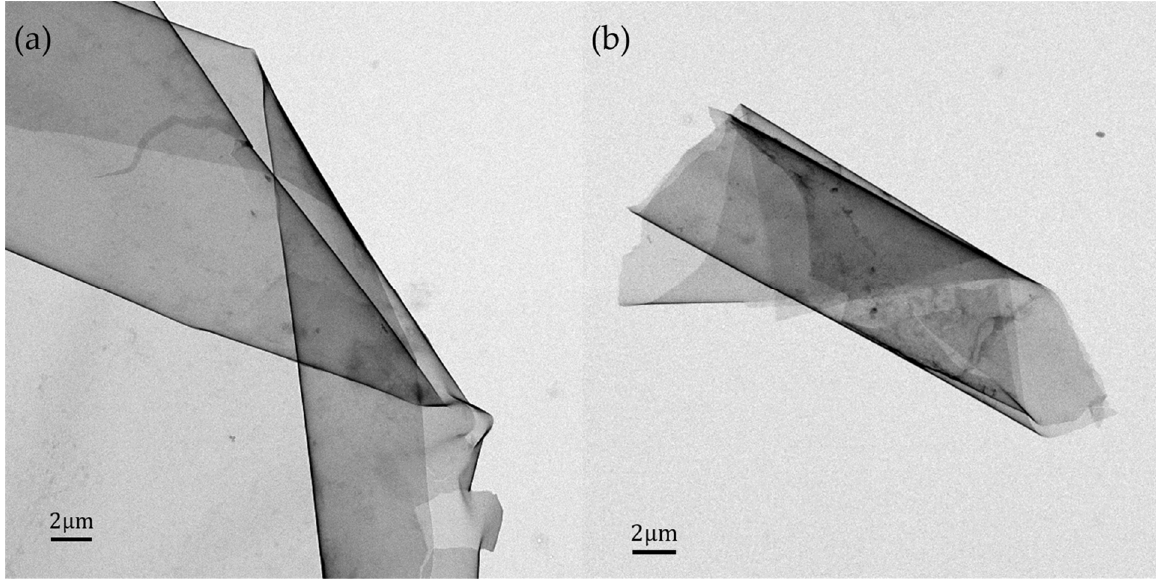
Figure 6. TEM micrographs of ( a ) g-POCN and ( b ) g-POCN sheet roll.